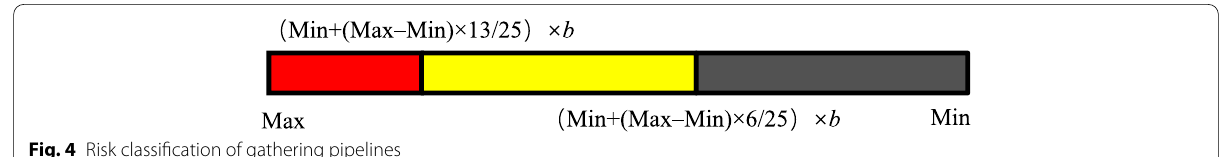
Fig. 4 Risk classification of gathering